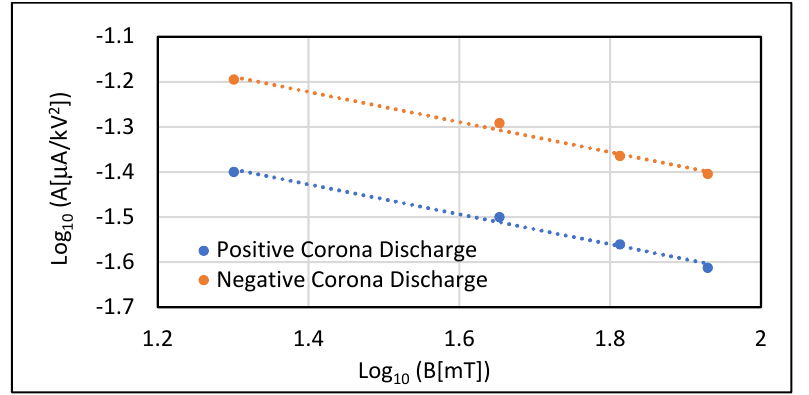
Figure 12. Geometric factor A versus the crosse magnetic field B for both discharge polarities on log 10 scale.